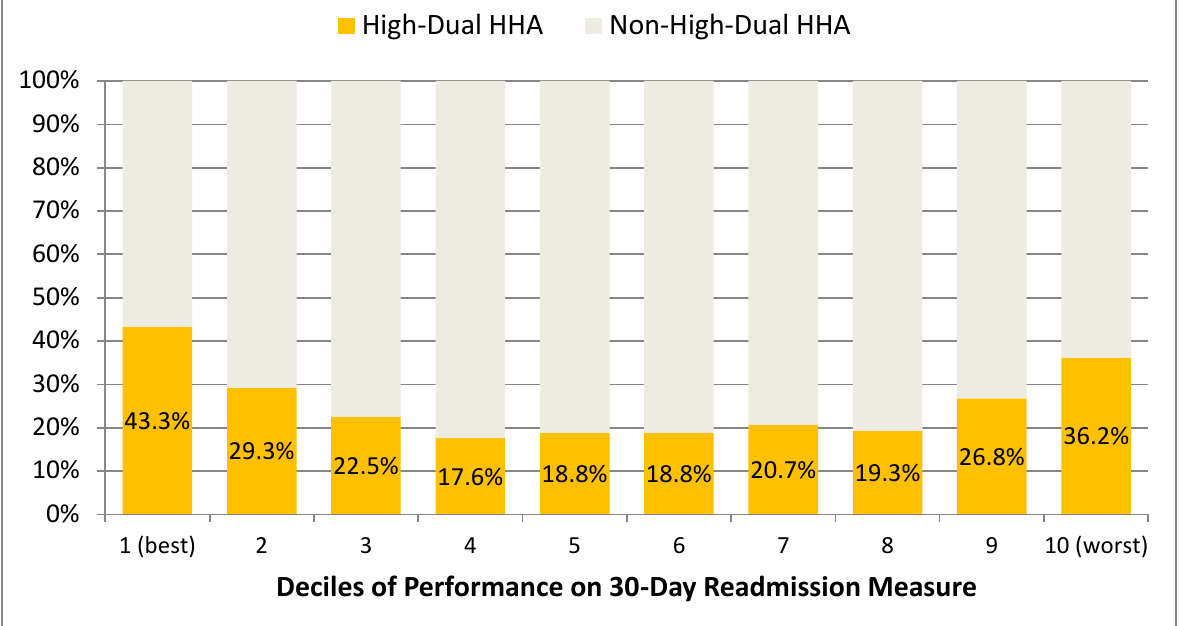
Figure 13.3: Distribution of High-Dual HHAs Across Deciles of Performance on Readmission